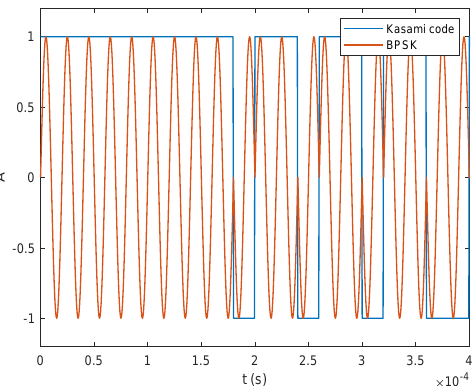
Figure 7. Example of the first chips of a Kasami sequence in conjunction with the modulated signal in BPSK.